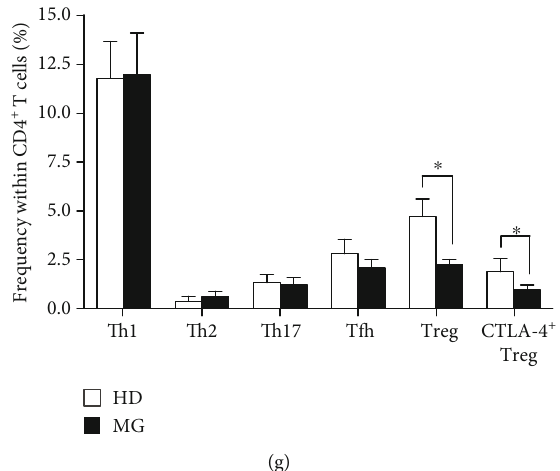
Figure 1: Phenotypic pro fi les of CD4 + T cell subsets reveal underrepresentation of Treg and CTLA-4 + Treg in MG patients. Representative FACS analysis of PBMCs from healthy donors and untreated MG patients was shown based on cell surface markers and/or intracellular cytokines for CD4 + IFN- γ + Th1 cells (a), CD4 + IL-4 + Th2 cells (b), CD4 + IL-17A + Th17 cells (c), CD4 + CXCR5 + PD-1 high Tfh cells (d), CD4 + CD25 + FOXP3 + Treg cells (e) and CD4 + CD25 + FOXP3 + CTLA-4 + Treg cells (f). G. Comparison of the mean frequency of CD4 + T cell subsets based on FACS analysis using the aforementioned markers in healthy donors ( n = 59 ) and untreated MG patients ( n = 39 ). Data are expressed as mean ± SD . ∗ P < 0 : 05